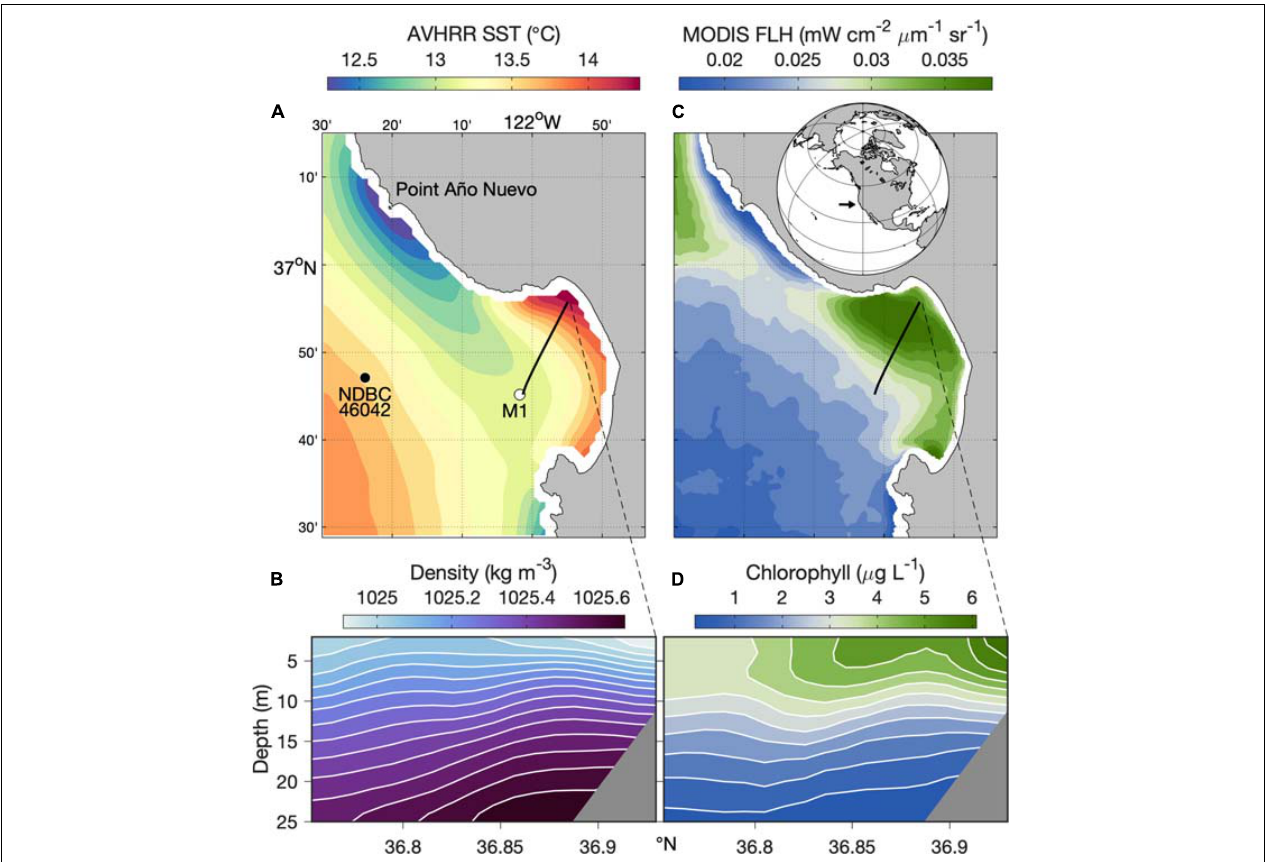
FIGURE 1 | Ecosystem patterns from long-term observations. Physical— (A) Sea Surface Temperature (SST) from the Advanced Very High-Resolution Radiometer (AVHRR) satellite sensors; the locations of mooring M1 (white dot), NDBC Station 46042 (black dot), and the Dorado AUV’s historical transect (black line) are indicated. (B) Mean water density along the AUV transect (black line in panel A ); isopycnals are indicated by white lines. Biological— (C) Normalized chlorophyll Fluorescence Line Height (FLH) from the Moderate Resolution Imaging Spectroradiometer (MODIS) satellite sensor; global location of the study region (inset, black arrow) is indicated. (D) Mean fluorometric chlorophyll concentration along the AUV transect (black line in panel C ). Satellite data (A,C) represent 6-year (2003–2008) mean conditions for March through November. In situ data (B,D) represent 5-year (2003–2007) mean conditions from approximately monthly surveys along the AUV transect shown in the satellite data images during April through November. Latitudinal range along the AUV transect (x-axes) is